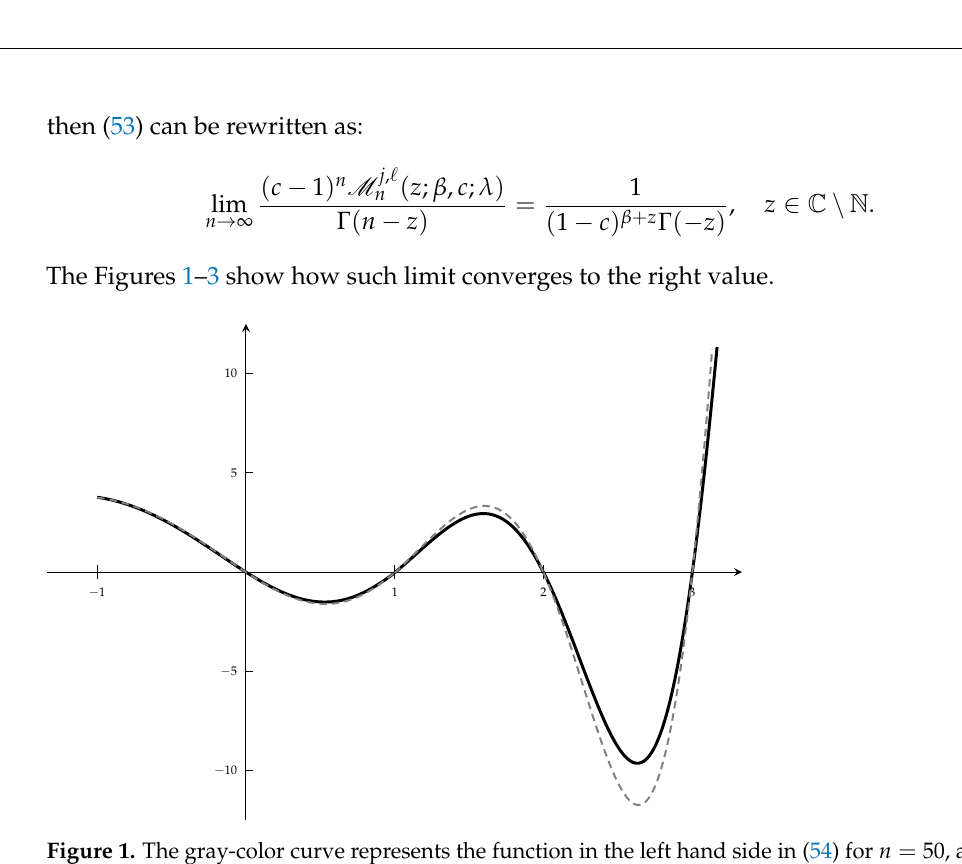
Figure 1. The gray-color curve represents the function in the left hand side in (54) for n = 50, and the black curve is the limiting function. Data: β = 7, c = 1/5, λ = 10 − 21 and j = 2.